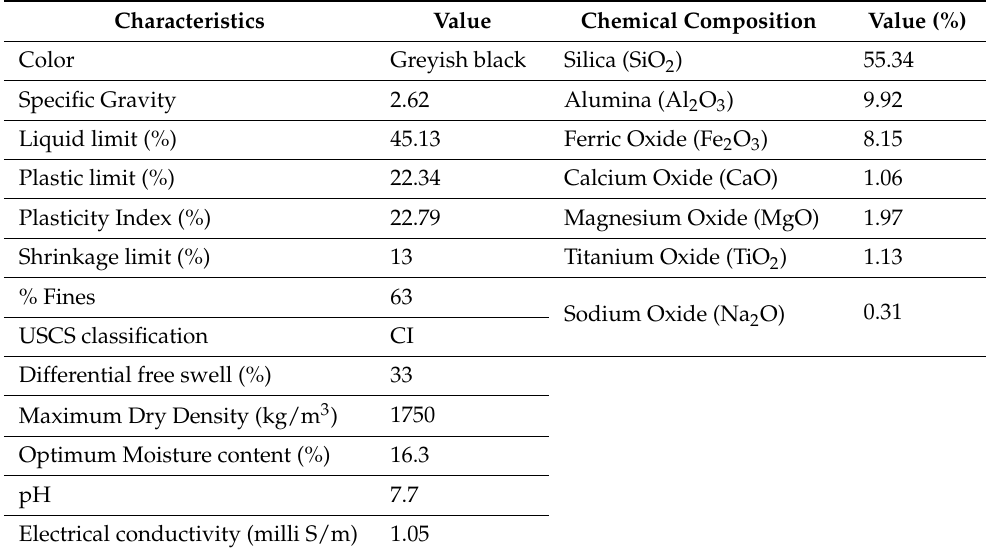
Table 1. Basic Characteristics and Chemical composition of